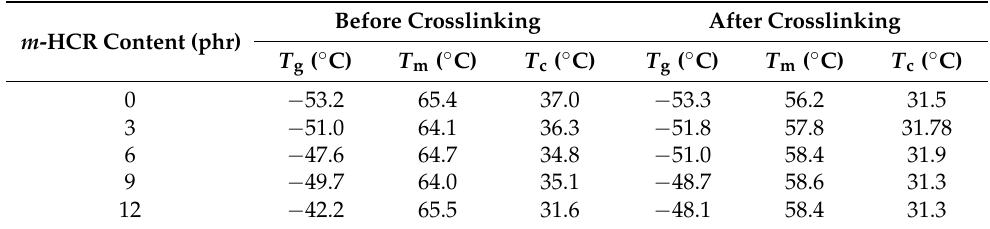
Table 1. Thermal characteristics of neat POE and POE blends with m -HCR before and after crosslinking.